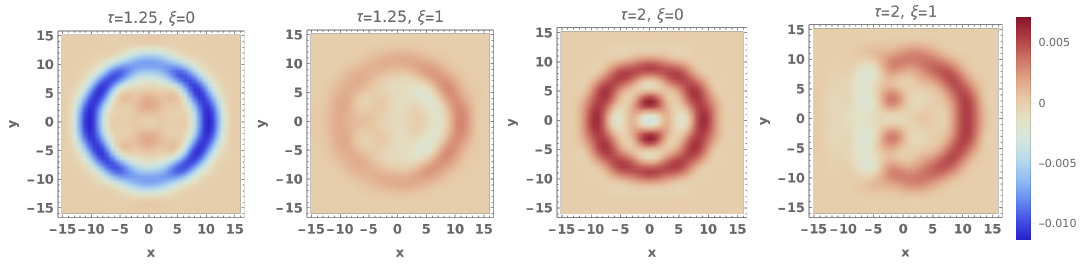
Figure 5 . First order corrections in transverse derivatives to the hydrodynamic residual ∆ at proper times τ = 1 . 25 , τ = 2 and rapidities ξ = 0 , ξ = 1 . Consistent with the agreement between the results at zeroth order and the exact results in [3], we find the first order correction to the residual ∆ to be less than 2% . This is a consequence of the fact that only fields in S 0 given in (4.43) contribute to the residual at first